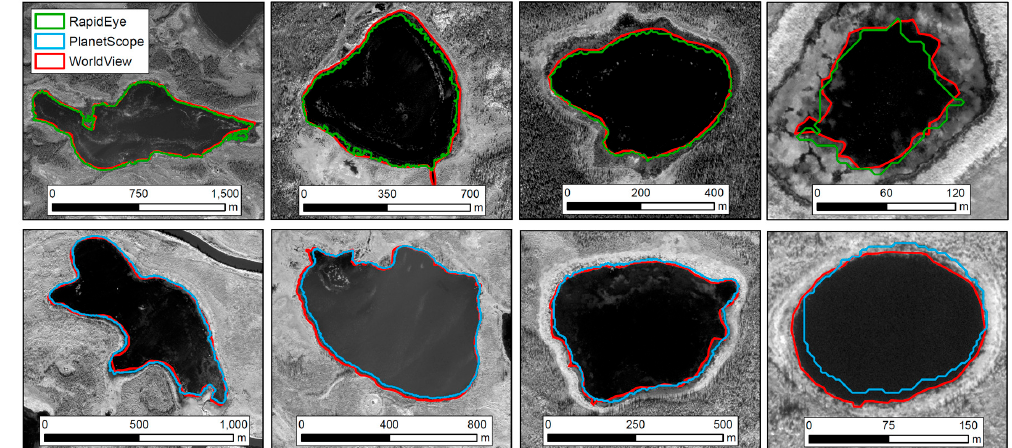
Figure 5. Lake shorelines delineated from PlanetScope (blue), RapidEye (green) and WorldView (red) imagery. PlanetScope and RapidEye shorelines shown represent automated extraction of >75% water area. WorldView shorelines are manually delineated. Imagery © 2016, DigitalGlobe, Inc., Westminster, CO, USA.